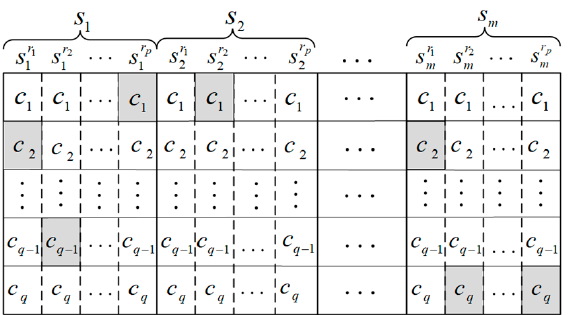
Figure 4. Searching space of the channel allocation problem.